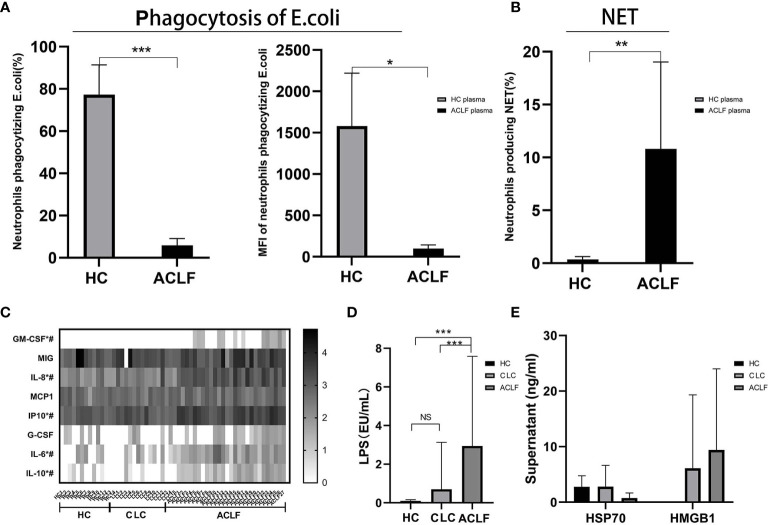
Circulation environment in hepatitis B virus related acute-on-chronic liver failure (HBV-ACLF) patients. (A) The percentage and mean fluorescence intensity (MFI) of neutrophils phagocytizing E.coli of healthy controls incubated with the plasma of ACLF(N=5) and healthy control (HC) (N=5). (B) The percentage of neutrophils producing neutrophil extracellular trap (NET) of healthy controls incubated with the plasma of ACLF (N=5) and HC (N=5). (C) Comparison of plasma levels of inflammatory mediators GM-CSF, MIG, IL-8, MCP-1, IP-10, G-CSF, IL-6, and IL-10 among patients with HBV-ACLF (N=27), CLC (N=15), or HC (N=14). * Represents a significant difference (P<0.05) between patients with ACLF and CLC; # represents a significant difference (P<0.05) between patients with ACLF and HC. (D) Comparison of plasma lipopolysaccharide (LPS) among patients with HBV-ACLF (N=22), CLC (N=18), or HC (N=16). (E) Comparison of DAMP molecules HMGB-1 and HSP among patients with HBV-ACLF (N=6), CLC (N=9), or HC (N=8). Data are expressed as mean ± standard deviation (SD). Statistical analysis was performed by the Mann-Whitney u test. NS, P > 0.05; *0.01 ≤ P < 0.05; **0.001 ≤ P < 0.01; ***P < 0.001.